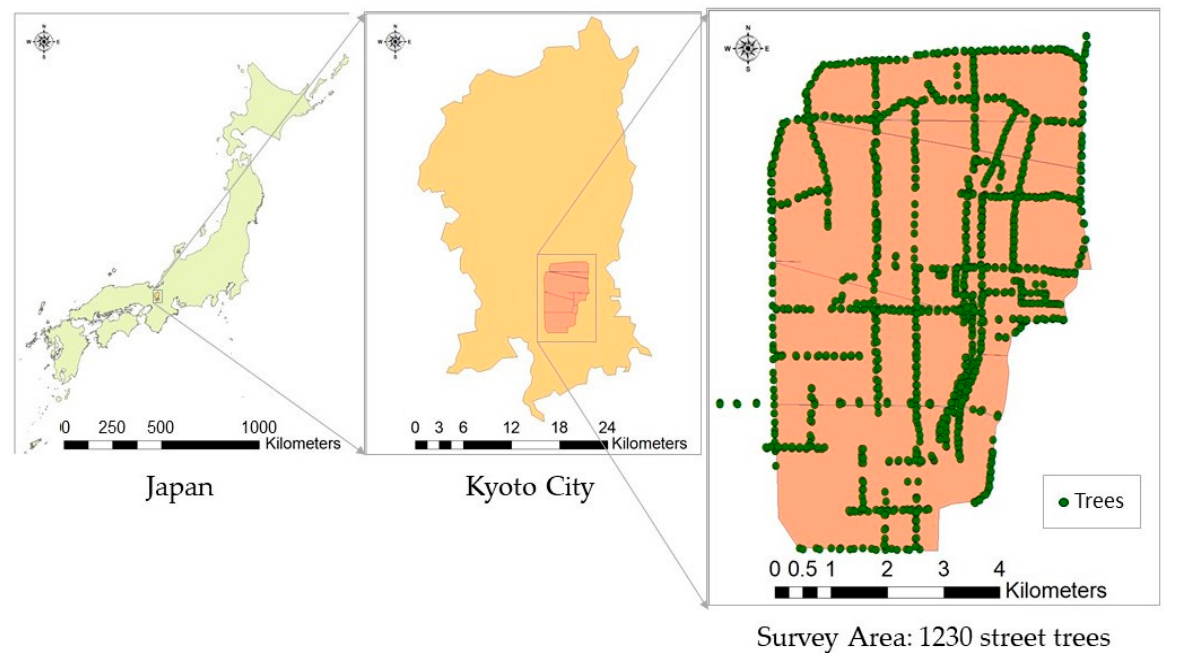
Figure 1. Location of sample street trees in the urban area of Kyoto City.